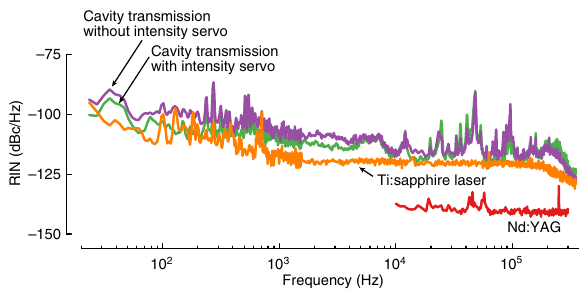
FIG. 8. The characterization of laser noise. The RIN of the Ti:sapphire laser (orange), the transmission of cavity 2 with (green) and without (purple) the intensity servo, compared with the RIN of a low-noise Nd:YAG laser